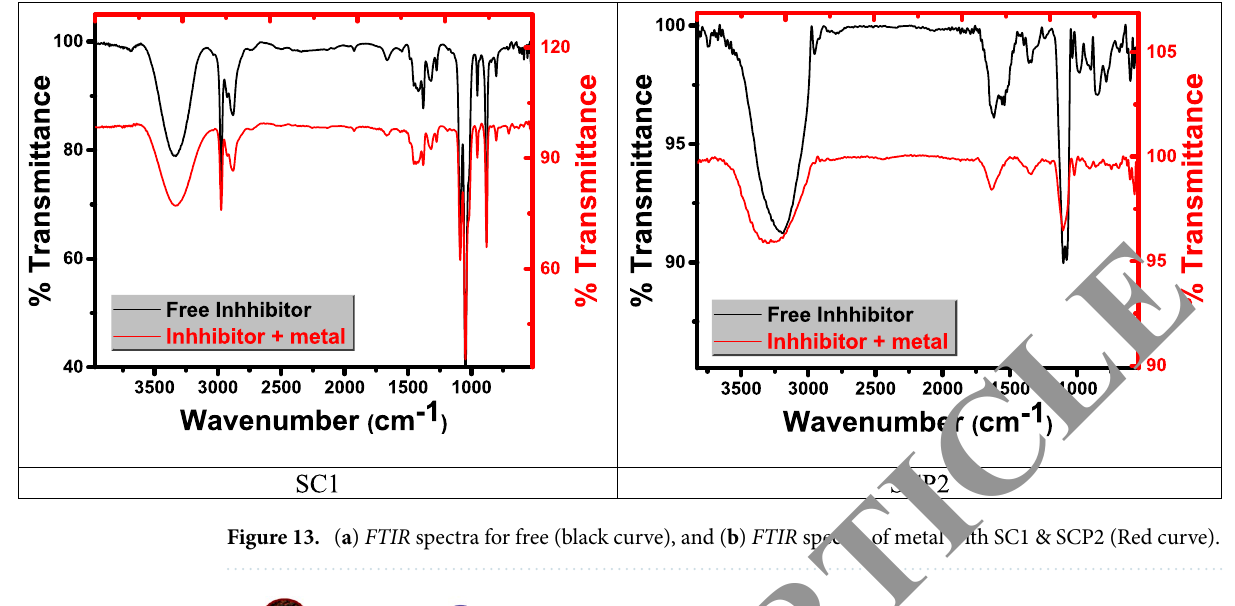
Figure 13. ( a ) FTIR spectra for free (black curve), and ( b ) FTIR spectra of metal with SC1 & SCP2 (Red curve).